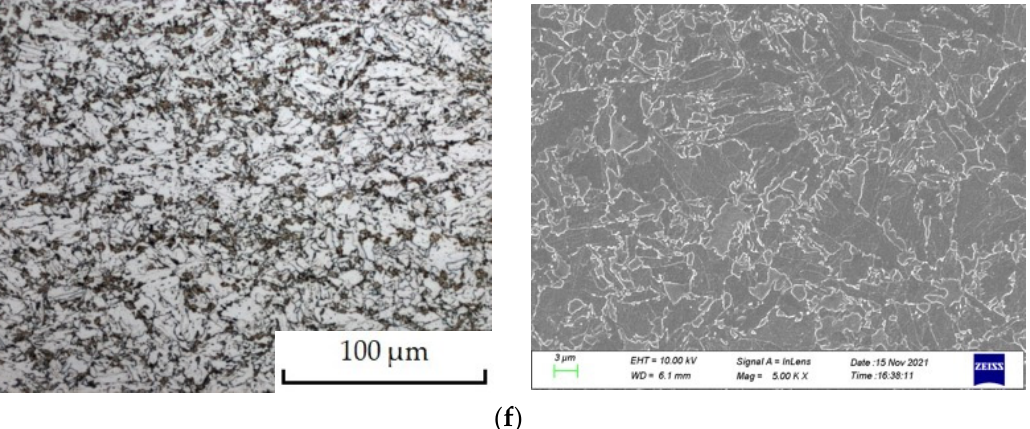
Figure 10. Microstructure of the welding thermal simulation samples (left: OM; right: SEM): ( a ) CGHAZ of 0 V; ( b ) CGHAZ of 10 V; ( c ) GRHAZ of 0 V; ( d ) GRHAZ of 10 V; ( e ) ICHAZ of 0 V; and ( f ) ICHAZ of 10 V.